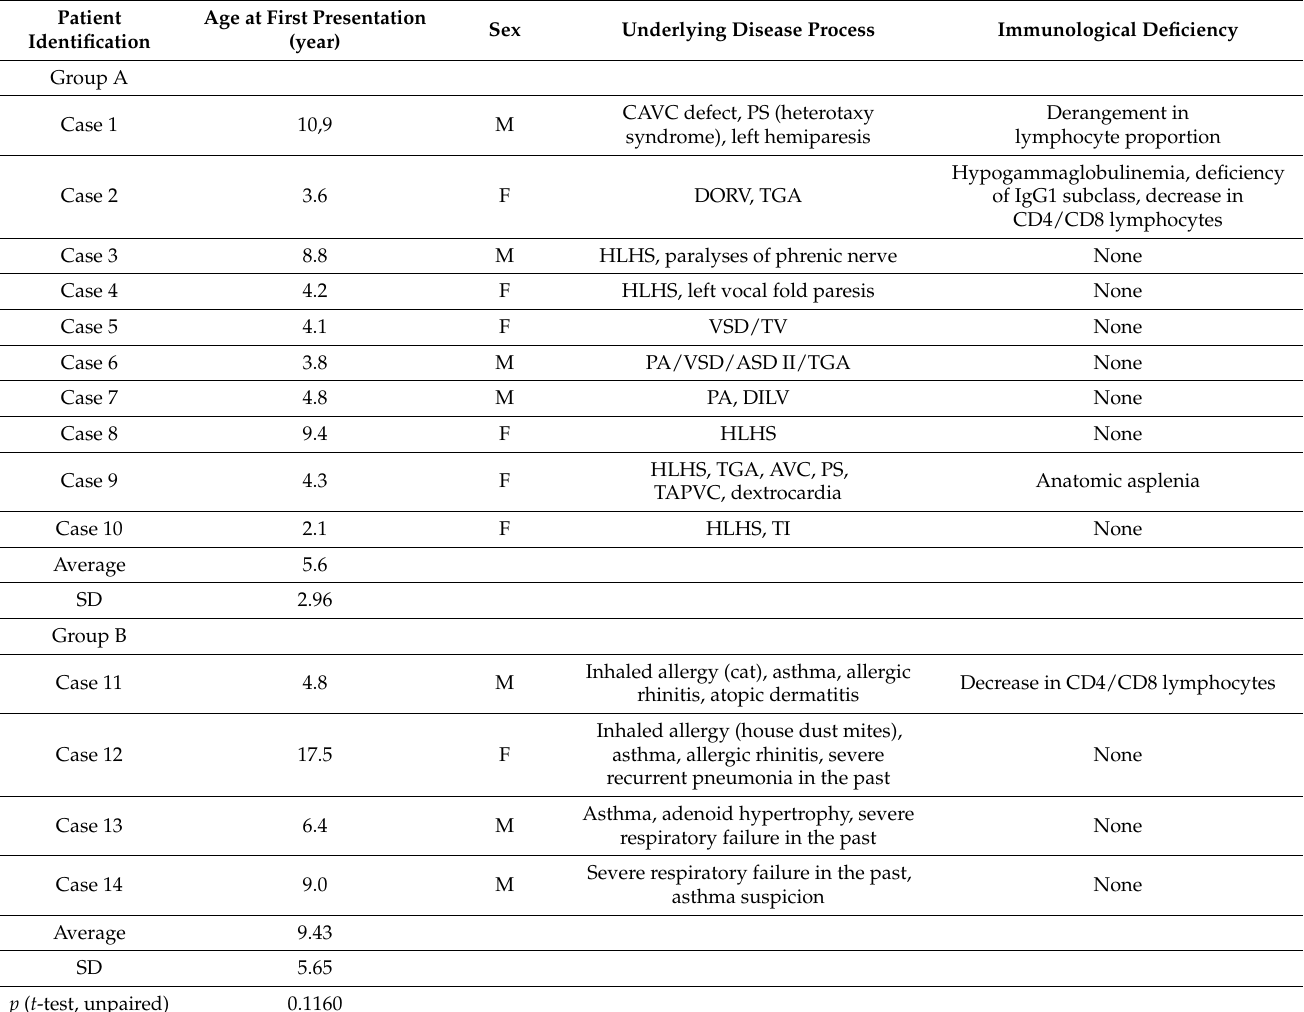
Table 1. Patient demographics.